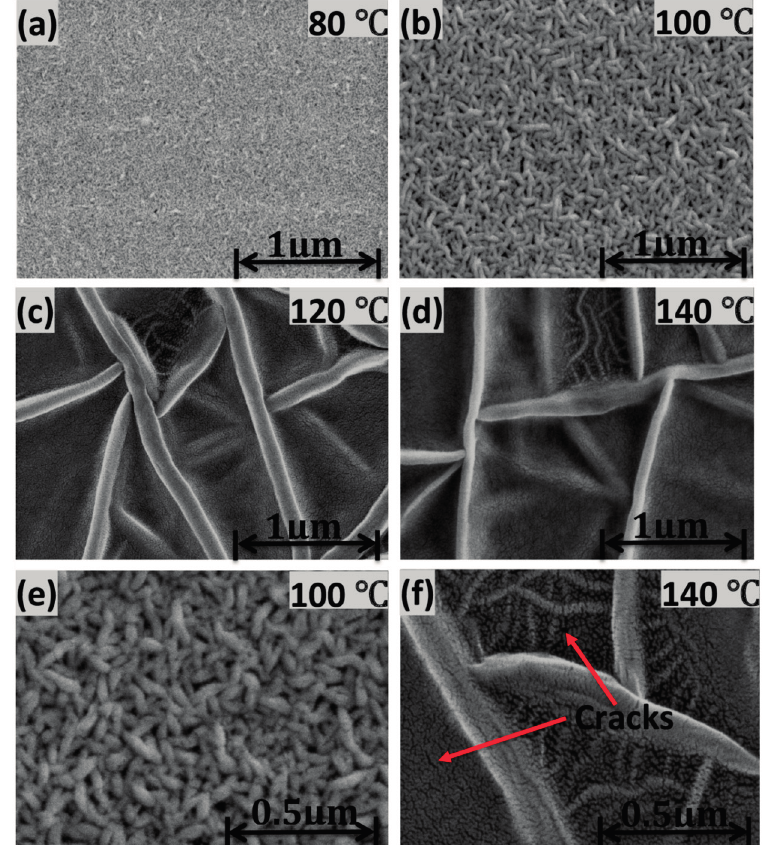
Figure 3. FESEM images of P(VDF-TrFE) annealed at ( a ) 80 °C; ( b ) 100 °C; ( c ) 120 °C; ( d ) 140 °C; ( e ) An amplified picture of (b); ( f ) an amplified picture of